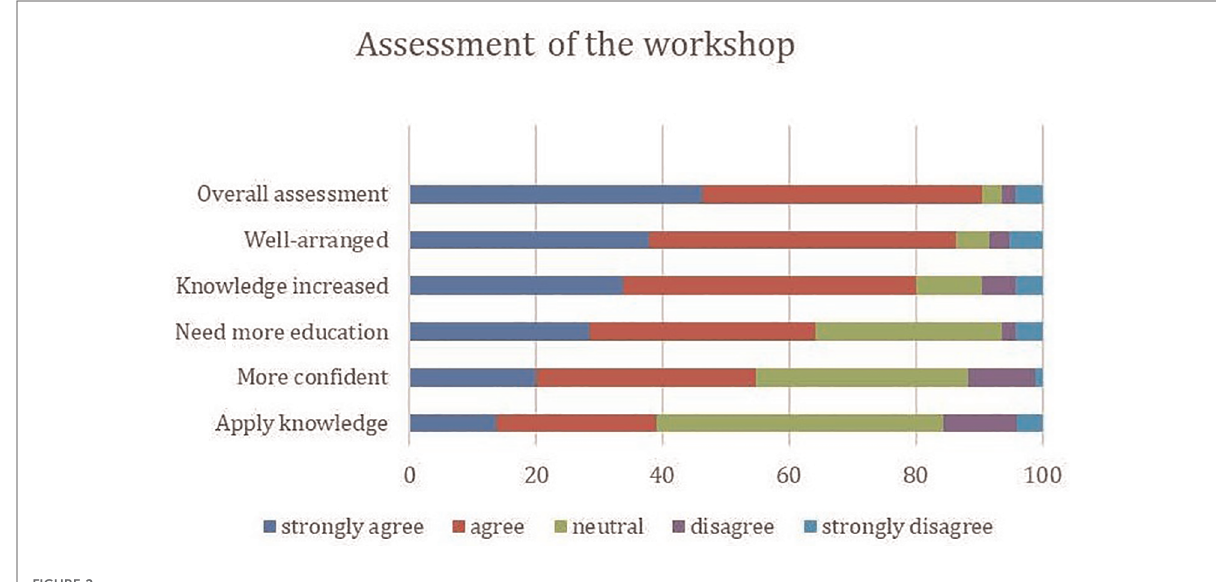
FIGURE 2 The participants ’ assessment of the special needs